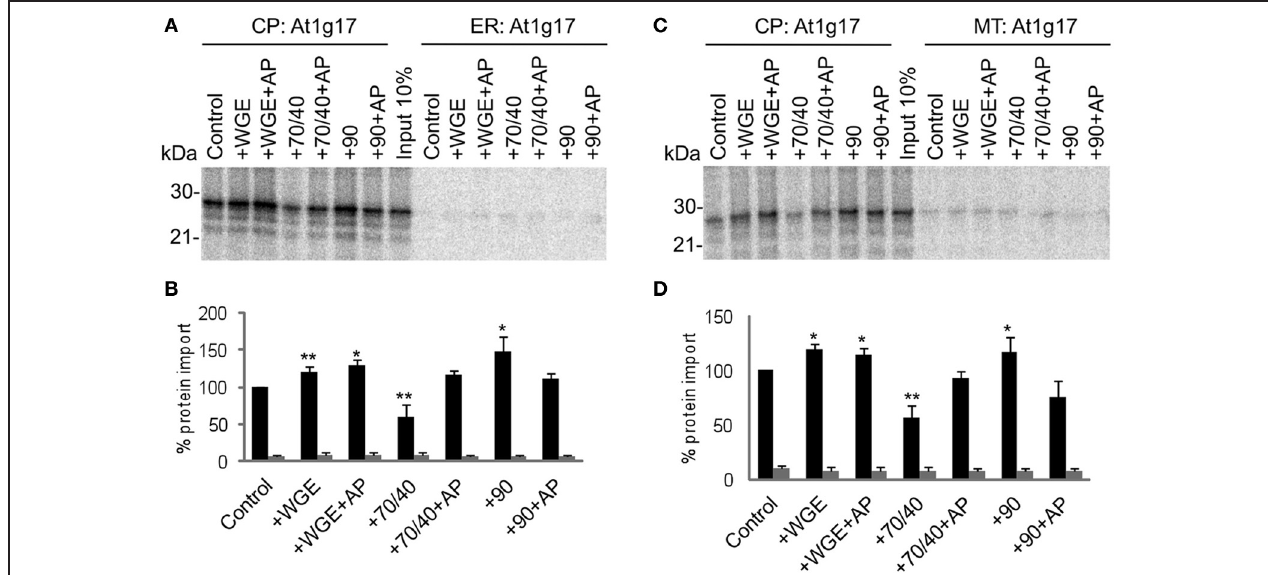
FIGURE 3 | At1g17 targets to chloroplasts efficiently and selectively under a wide range of cytosolic conditions. (A) Radio-labeled At1g17 protein derived from RNCs was incubated in a competitive targeting assay with chloroplasts (CP) and ER, with the addition of cytosolic components as indicated; control is buffer only, WGE is wheat germ extract, chaperones (Hsp) are indicated by their numbers (70/40 or 90), and AP represents apyrase treatment. Membranes were refractionated and washed with carbonate for analysis by SDS-PAGE. 10% of protein input is shown, and the protein molecular weight markers are indicated in kDa. (B) Quantification of